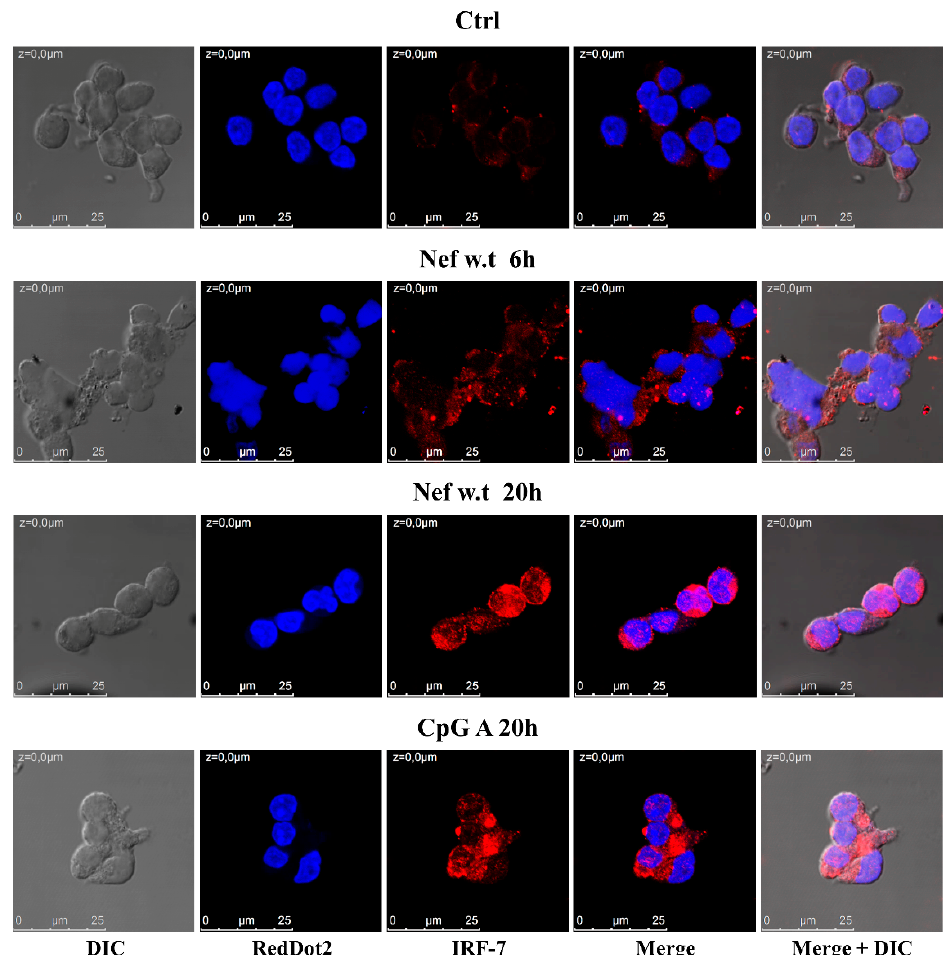
Figure 3. IRF-7 is upregulated and translocates to the nucleus after treatment with Nef protein. 0.5 × 10 5 pDCs were treated for 6 h and 20 h with 300 ng/mL of myrNef SF2 w.t or for 20 h with CpG A (1 µ M), as a positive control. Ctrl: untreated cells. Cells were afterwards fixed in PFA 4%, permeabilized and incubated with anti-IRF-7 antibody and with a secondary antibody conjugated with AlexaFluor546 (red), as reported in Materials and Methods. Nuclei (blue) were stained using the dye RedDot2. Images were acquired with the confocal microscope Leica TCS SP5 and processed using the software LAS AF version 1.6.3 (Leica Microsystems). Objective 63.0X. DIC: Differential Interference Contrast. Scale bars 0–25 µ m. For further details see Materials and Methods section.